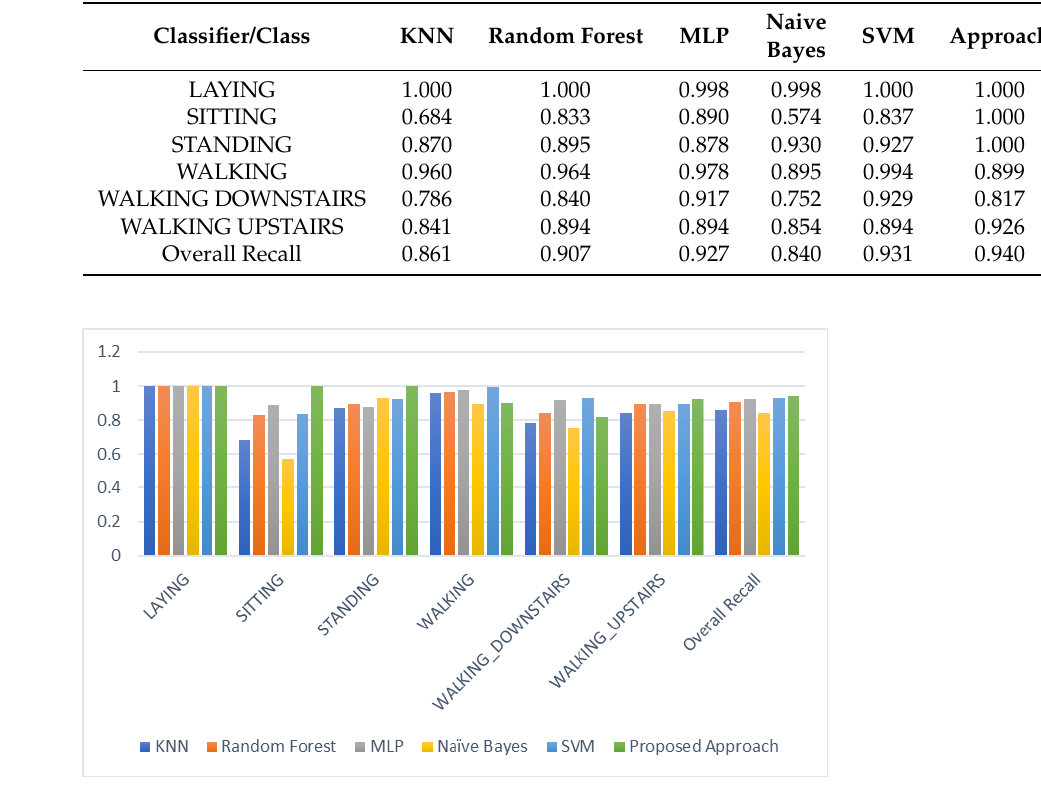
Figure 8. Detailed Recall by Class. Table 5. Detailed F-measure by